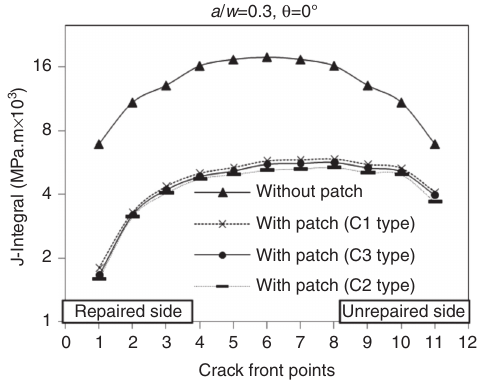
Figure 25 Effect of different repairs on